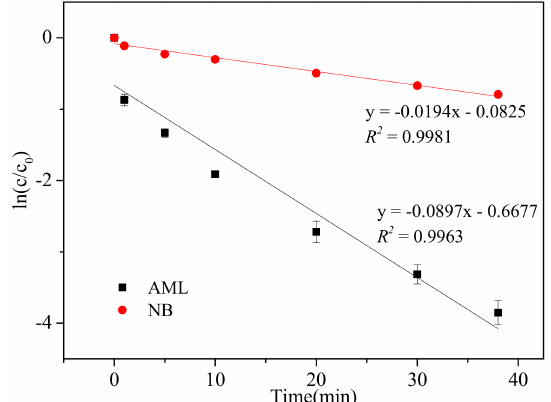
Figure 7. AML and NB degradation in the UV / chlorine process ([AML] 0 = [NB] 0 = 10 µ